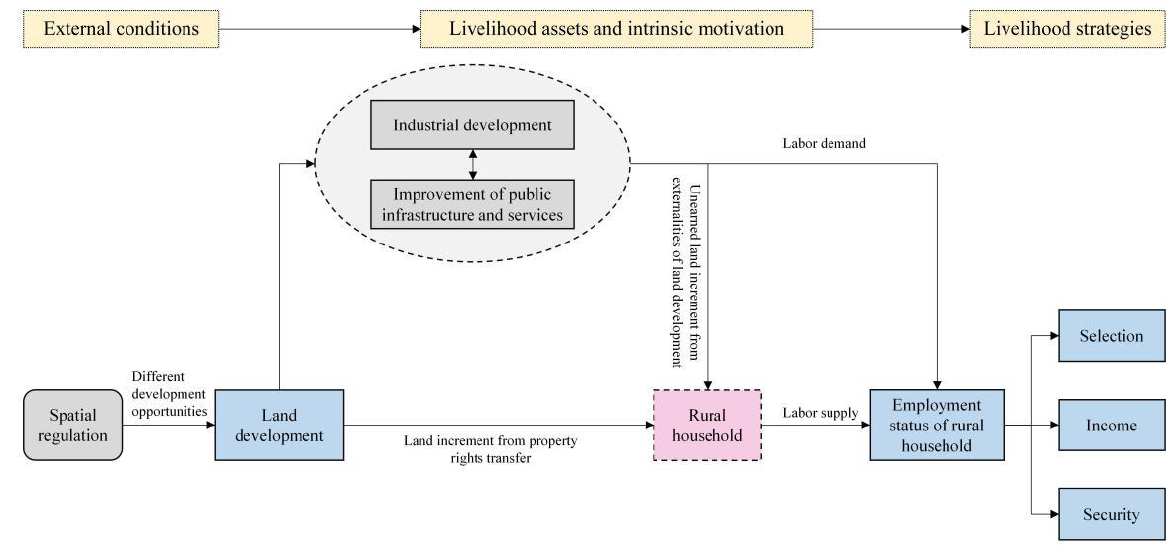
Figure 1. The theoretical framework.